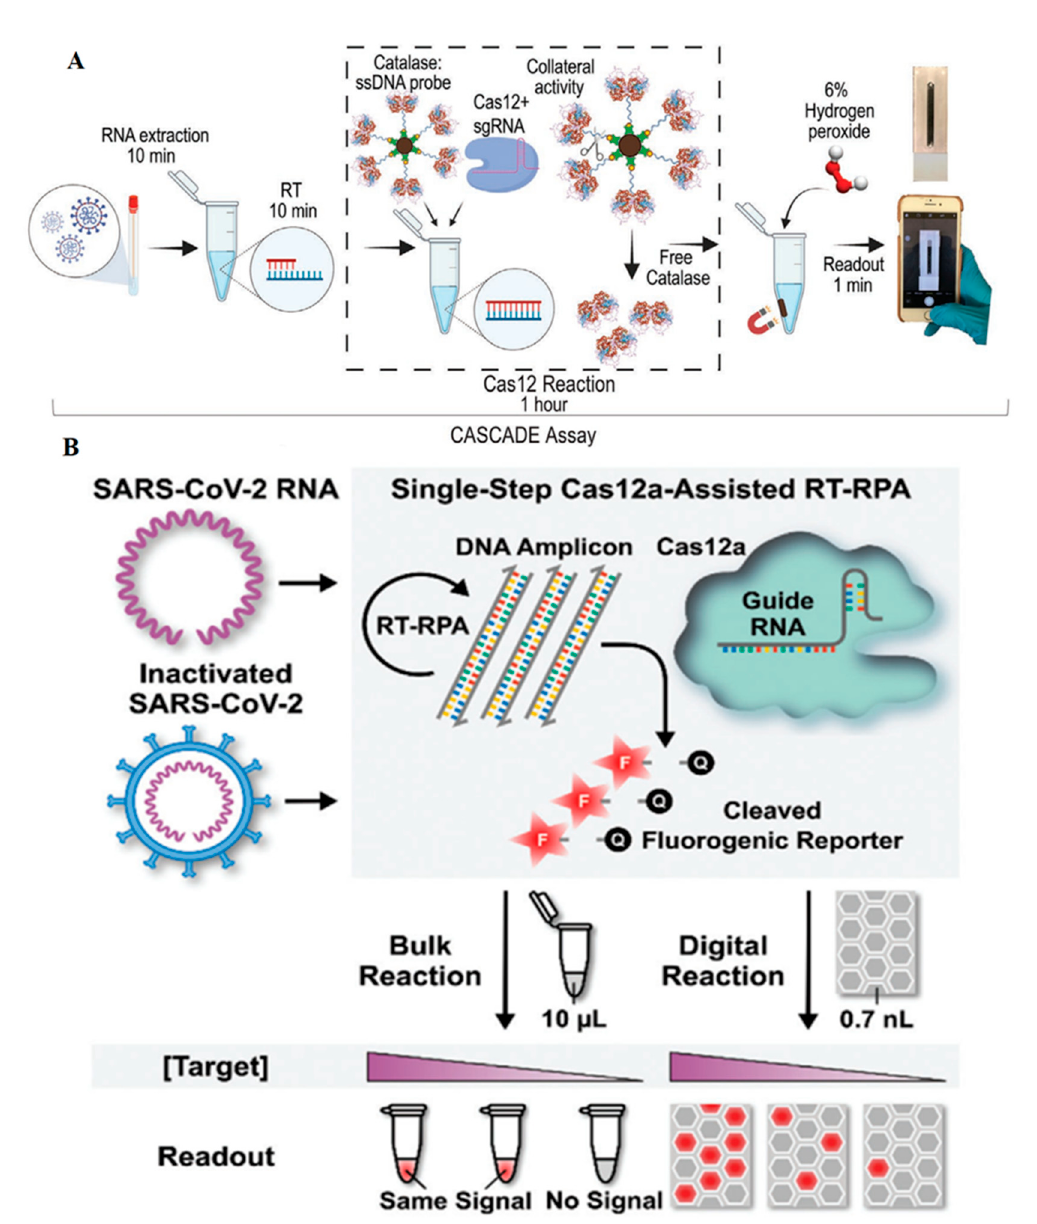
Figure 1. ( A ) CASCADE assay based on the trans cleavage activity of Cas12, in which the catalase enzyme produces gas bubbles for visual detection [32]. ( B ) deCOViD assay in which fluorophore- quencher probes break after the activation of Cas12. Cas12 trans cleavage activity and the microfluidics provided the digitized fluorescent signals [24]. Figures reprinted with permissions.